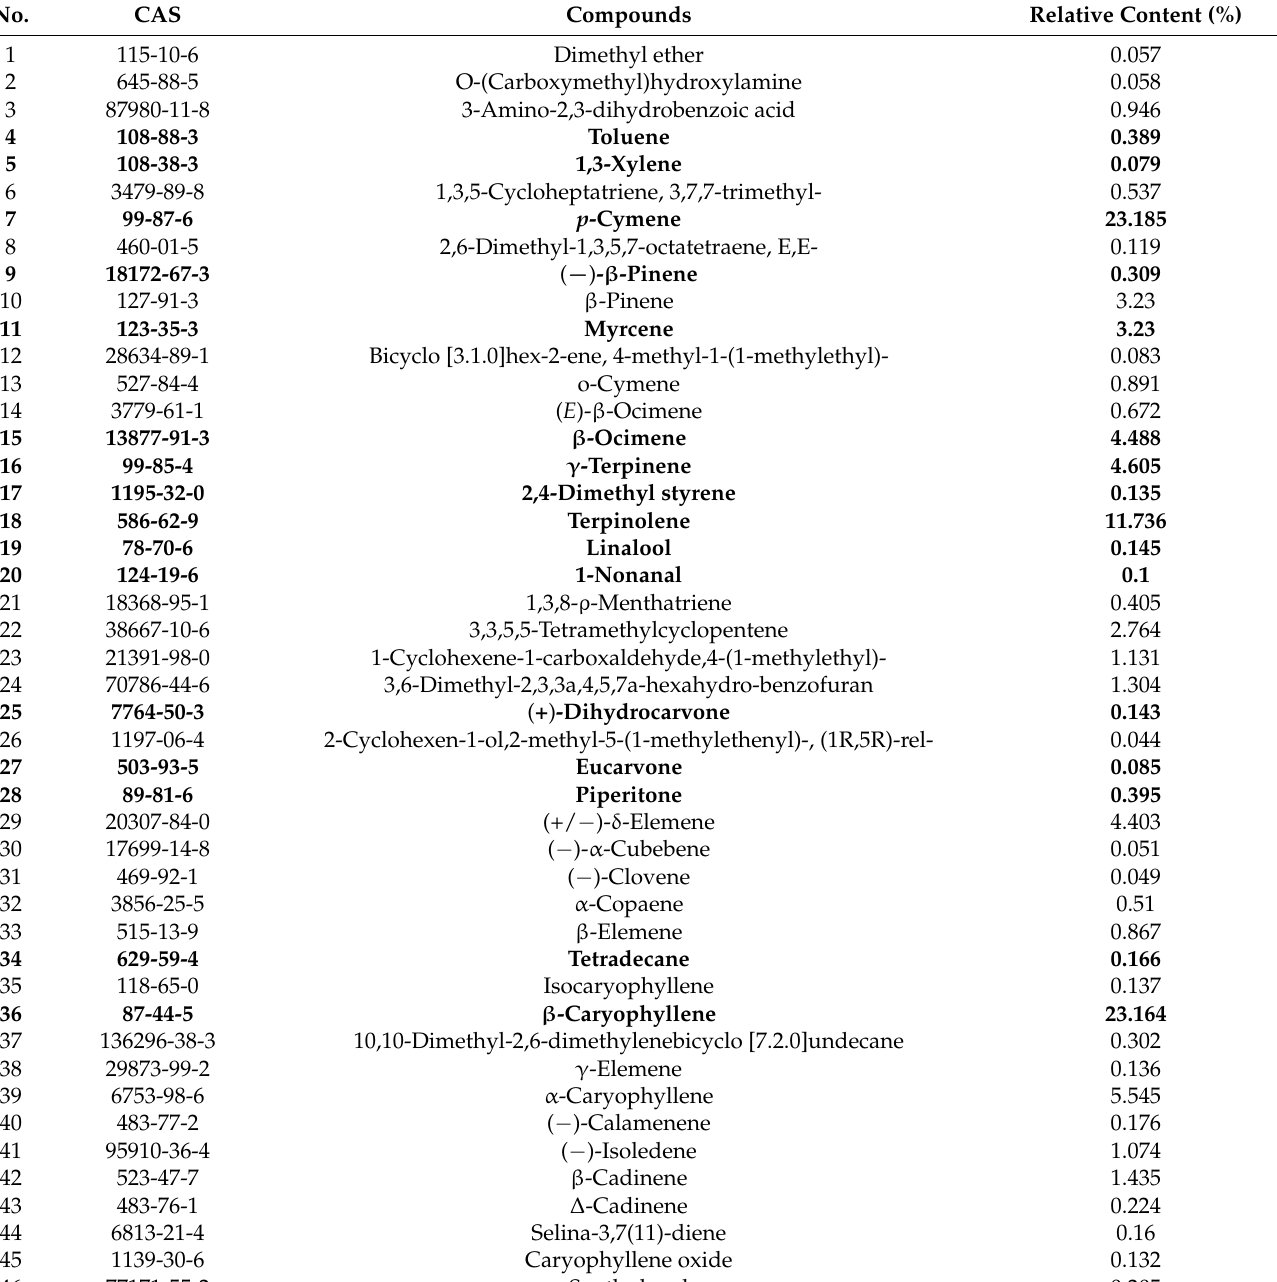
Table 2. Number and relative peak area (% of single compounds) of compounds detected in flower volatile samples of